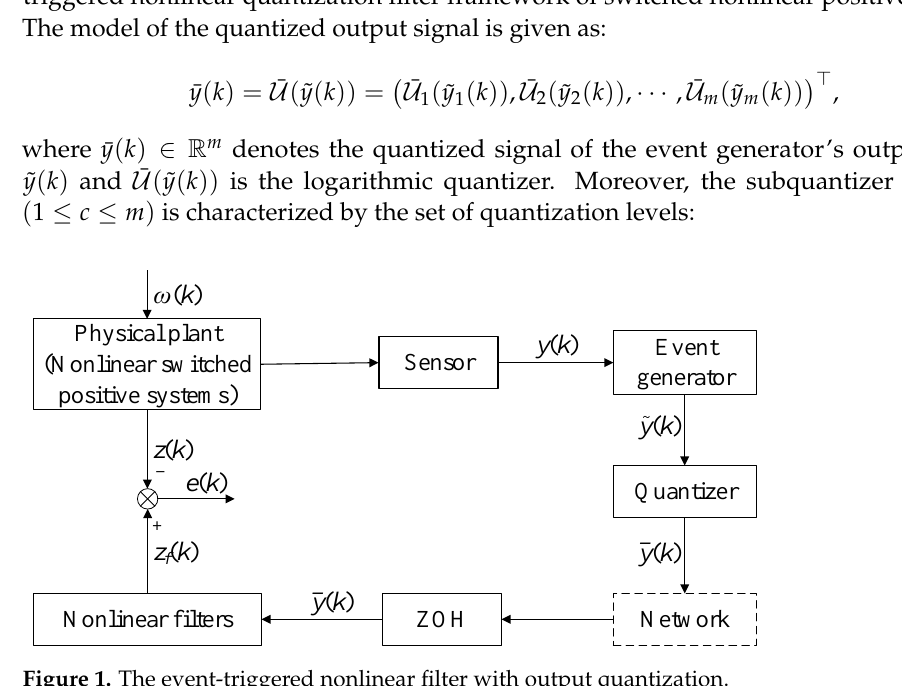
Figure 1. The event-triggered nonlinear filter with output